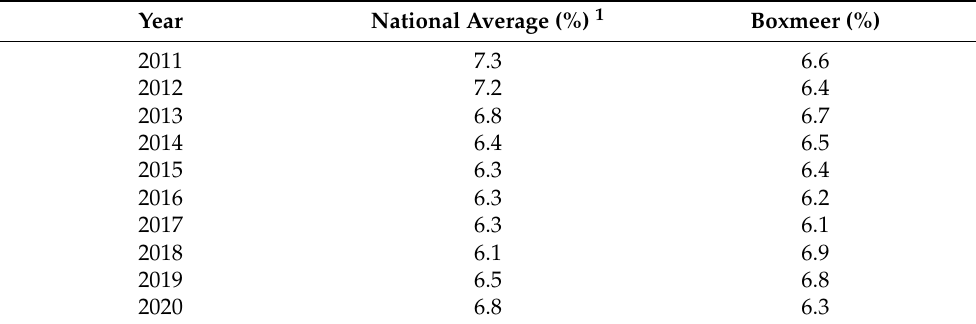
Table 1. Staff volume in fte’s per 1000 inhabitants (source: https://www.aeno.nl accessed on 21 June 2021).